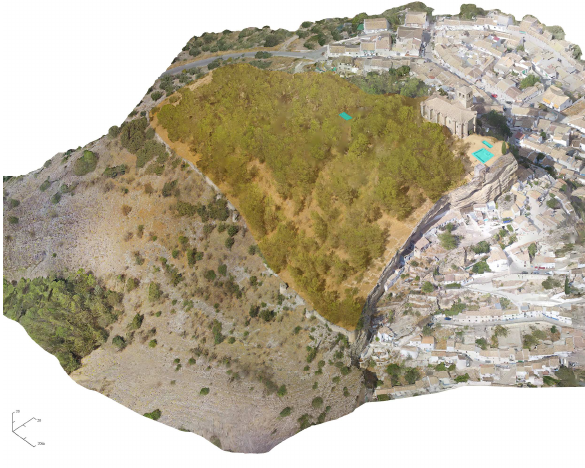
Figure 8. Photogrammetric model of the fortress of Montefrío.